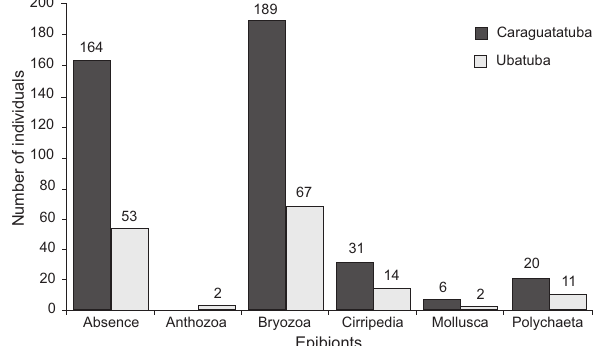
Figure 1. Epibionts found on gastropod shells occupied by